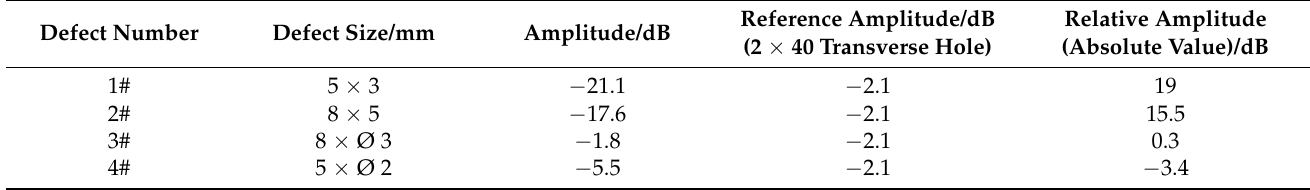
Table 2. Analysis of simulation results of different types of